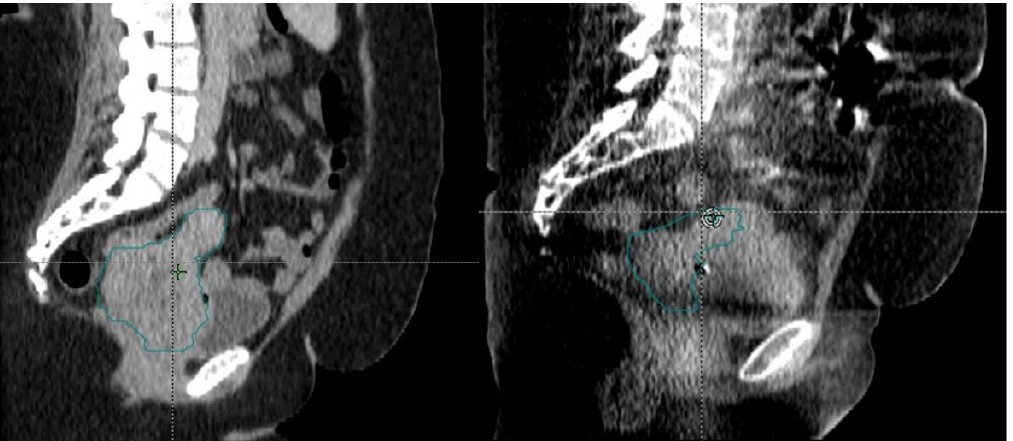
Figure 5. Change in size of uterocervix between fraction 1 and fraction 27 of our patient’s radiation treatment course. The uterocervix CTV is in green.